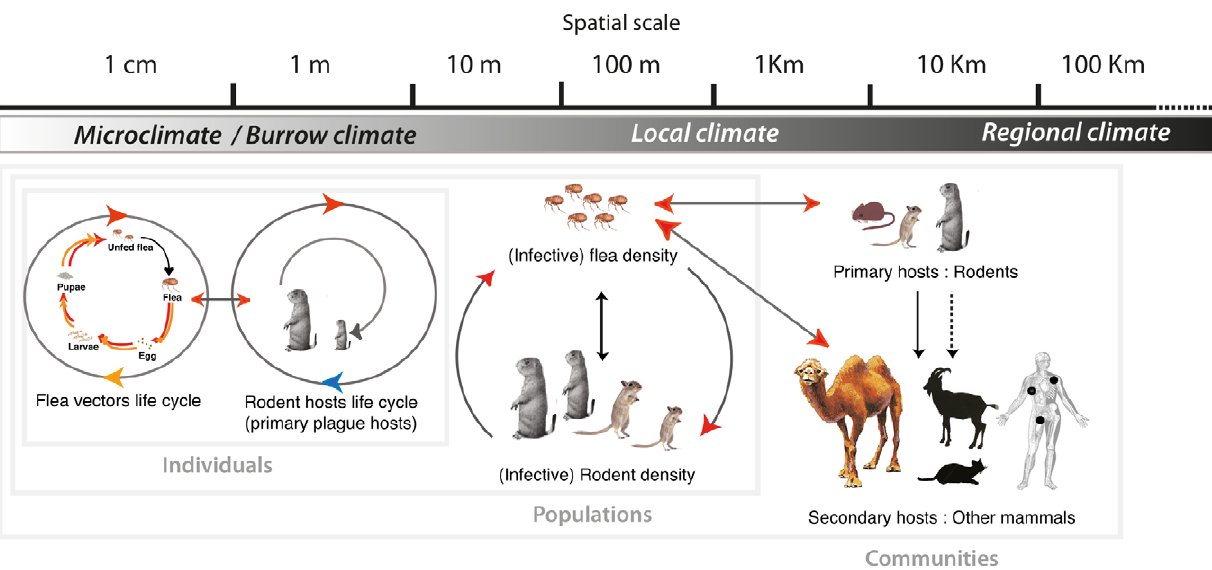
Figure 2. Illustration of the abiotic environment impact on the plague cycle as a function of spatial scale. Arrows represent connections affected by climate (see Figure 1 for the meaning of color coding). Most climate variables act over a wide range of scales and only the effects we deemed most important are represented. At the level of individuals, populations and communities hosts and vectors are influenced by climate variability at the relevant scale (local or regional). At the smaller scale, the burrow acts as a filter on climate variables. Note that secondary hosts are placed at the kilometer and larger scale on the basis of the type of information generally available regarding their infection.